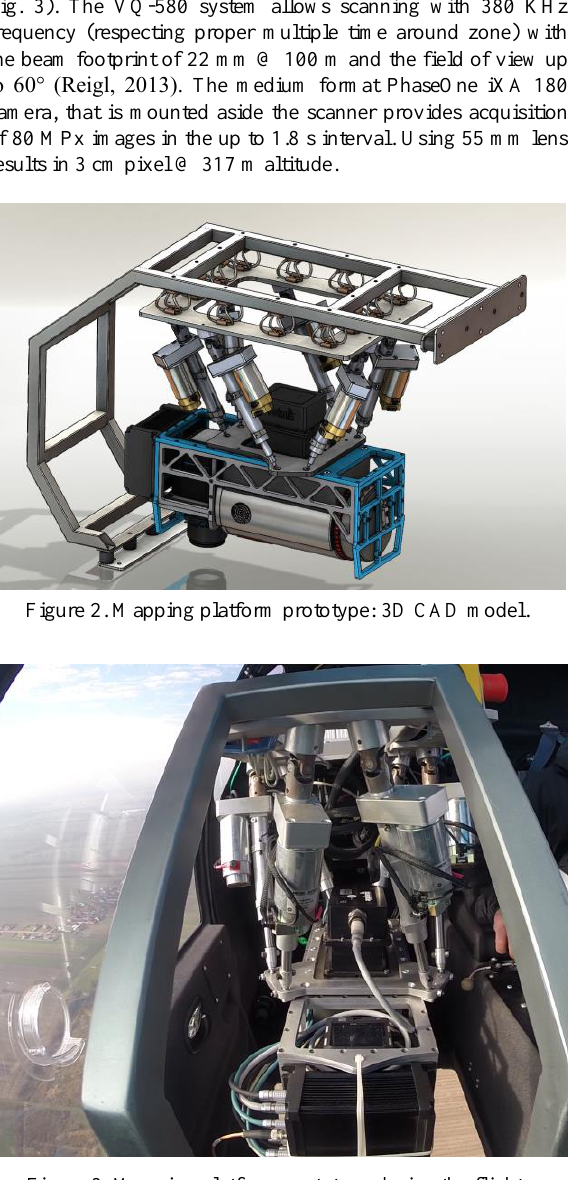
Figure 3. Mapping platform prototype during the flight. Image from the GoPro